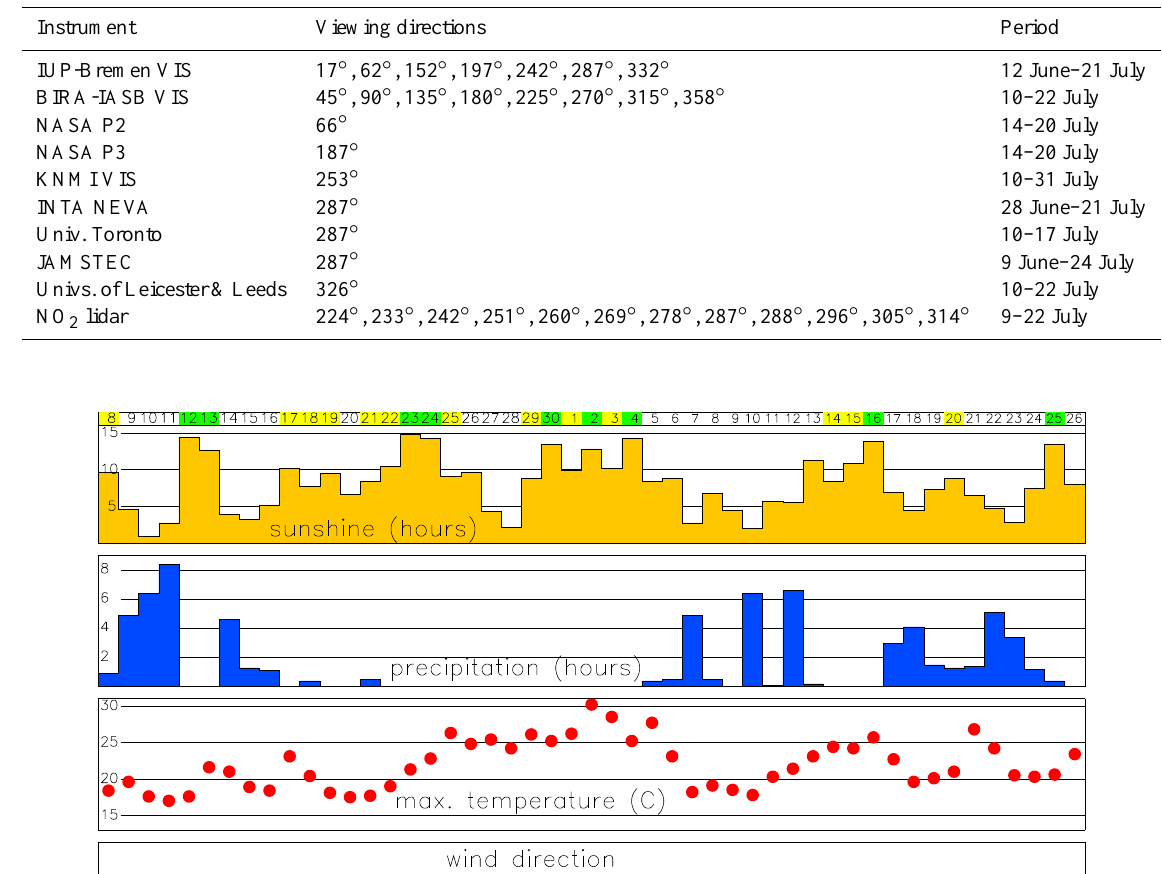
Table 3. Instruments participating in the experiment with multiple azimuthal viewing directions.